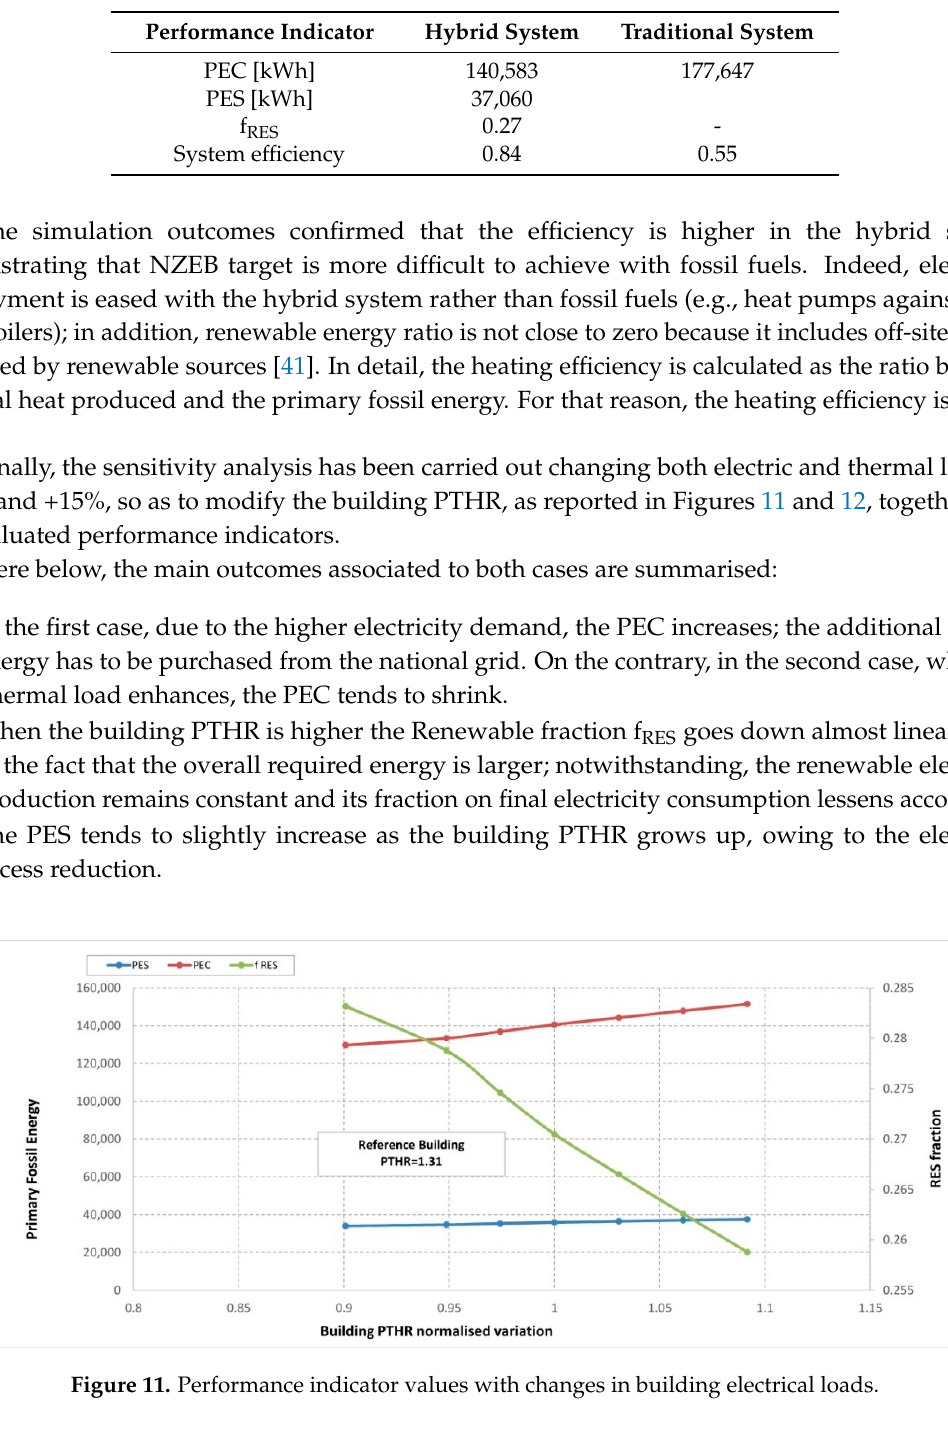
Table 6. Heat Transcritical hybrid and traditional systems performance indicators.